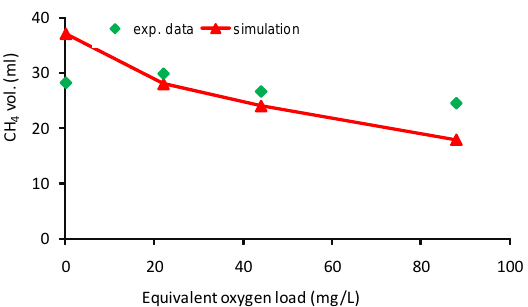
Figure 4: Experimentally determined and simulation predicted ultimate methane generation vs.